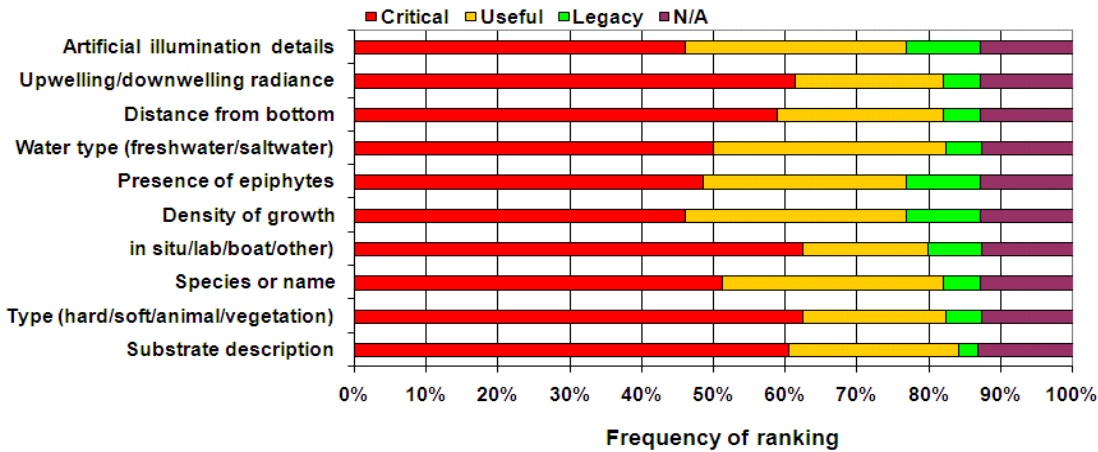
Figure 5. Frequency of criticality ranking for ―substratum target‖ metadata ( n =